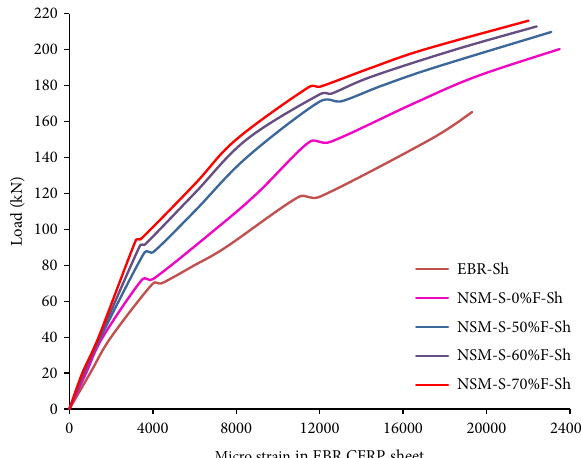
Figure 10. Load versus tensile strain in CFRP sheet